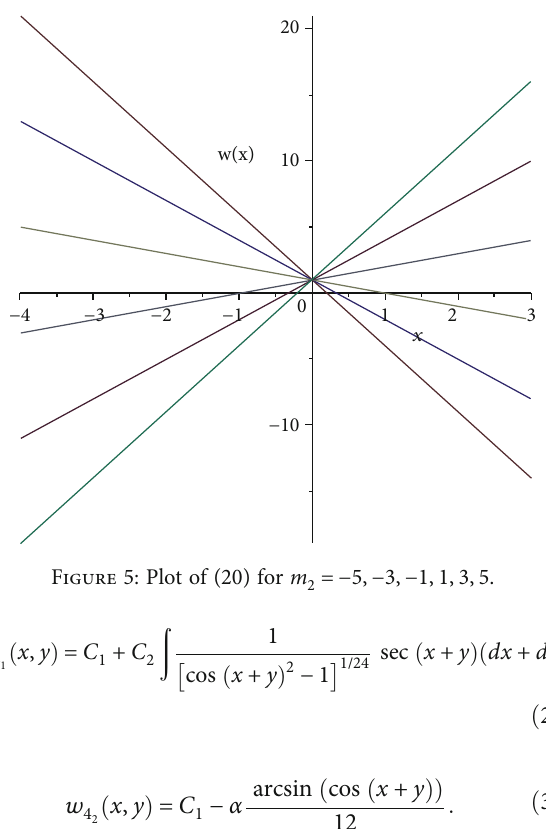
Figure 5: Plot of (20) for m